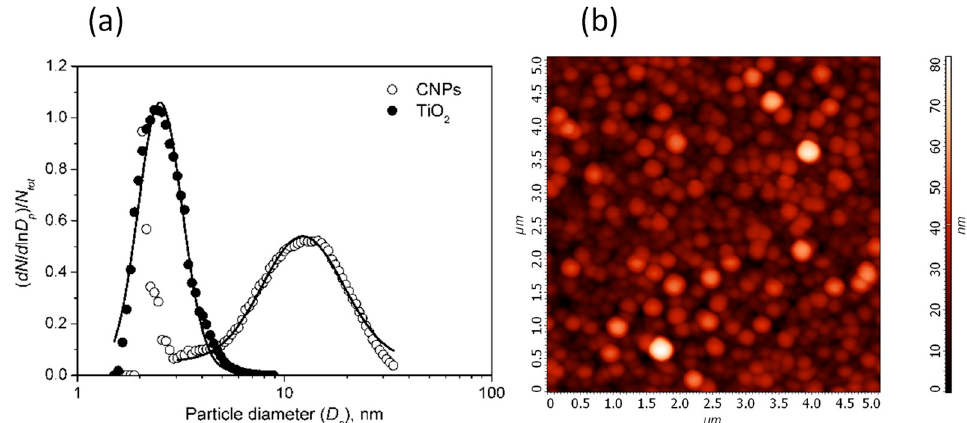
Figure 2. ( a ) Size distributions of CNPs (empty circles) and TiO 2 particles (filled circles). The contin- uous lines are the fit with the lognormal function (CNPs distribution has been fitted for D p > 3 nm). ( b ) AFM image of the film showing the typical granular structure produced by the self-assembling of particles during the thermophoretic sampling.